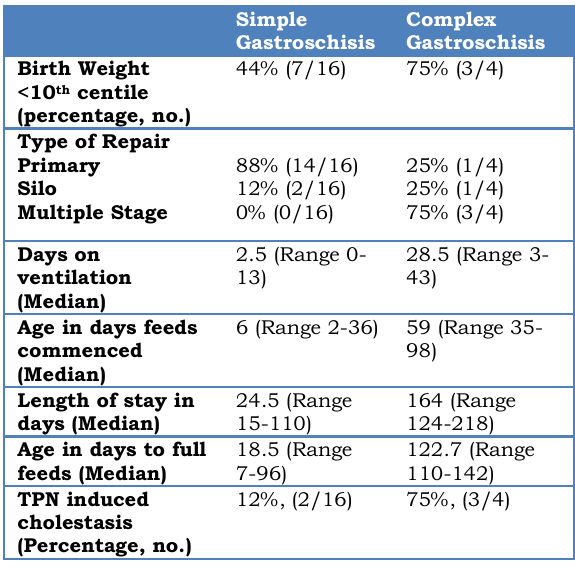
Table 3: Comparison between Simple and complex Gastroschisis